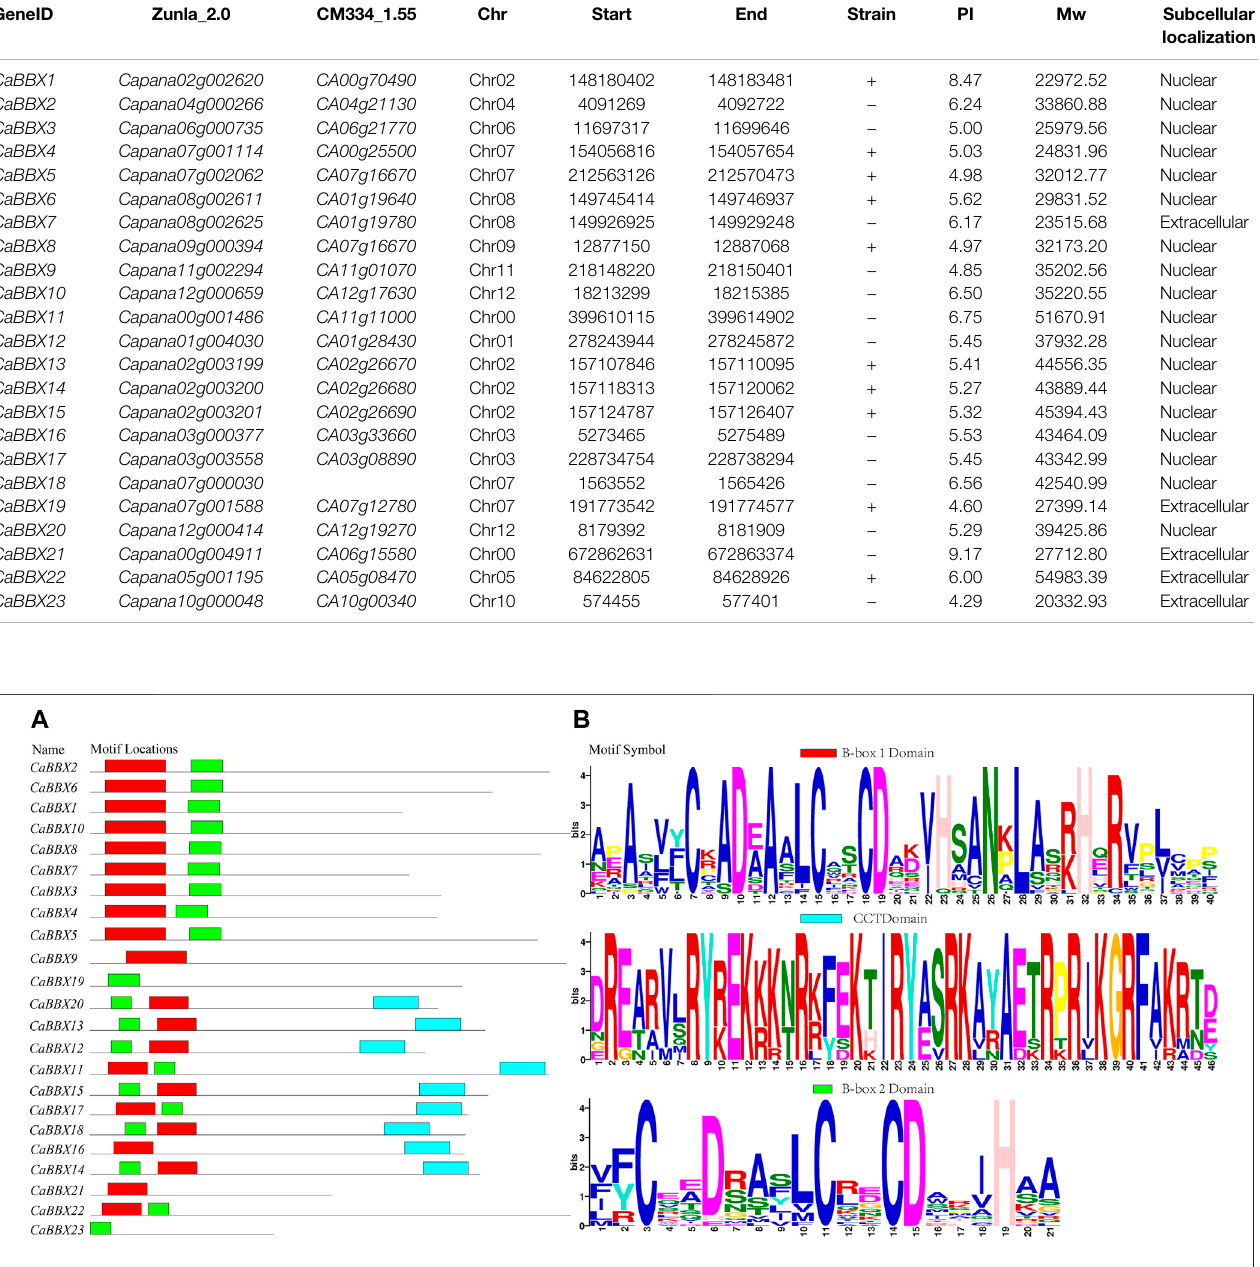
Frontiers in Genetics |